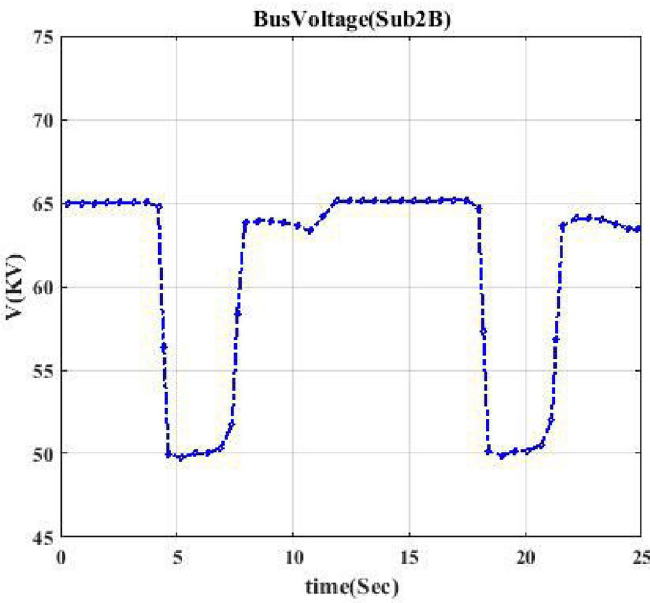
Fig 11. Voltage profile for switching the induction motor. This curve indicates the voltage curve when the induction motor is disconnected from the system.